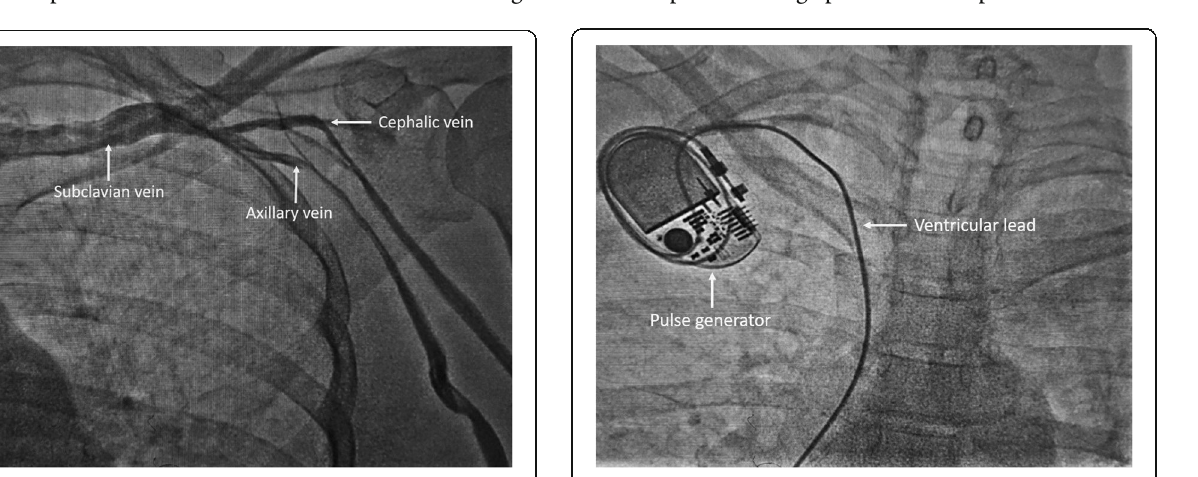
Fig. 3 Final implantation of single-chamber permanent pacemaker from the right